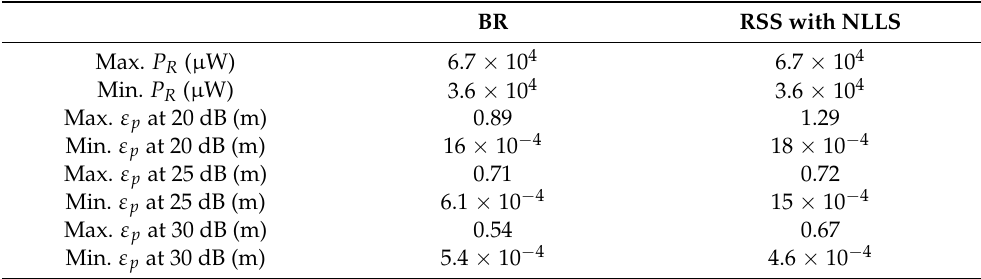
Table 5. Final observations of the comparison of BR and traditional RSS with NLLS